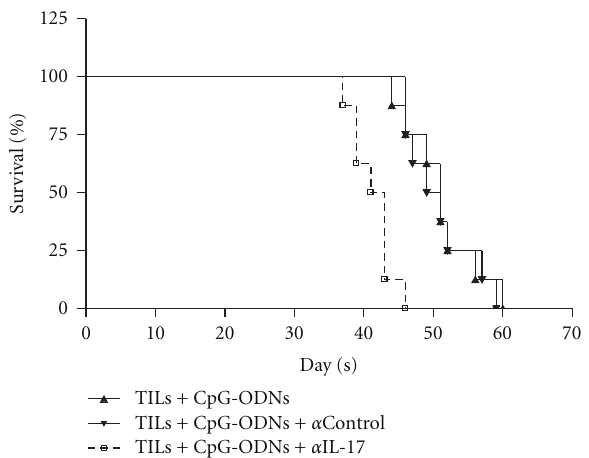
Figure 6: Neutralization of IL-17 reduced the survival of human lung cancer bearing nude mice. TILs were collected from lung cancer patients ( n = 12) and treated with CpG-ODNs or control CpG-ODNs as described in Materials and Methods . 1 × 10 7 autologous TILs were transferred into the tumor bearing Balb/c nude mice with 100 ug CpG-ODNs or control CpG-ODNs through tail vein. After 2 days, the recipients were injected intravenously with anti-IL-17 (5ug/g) every seven days. Then, the survival of tumor bearing nude mice was